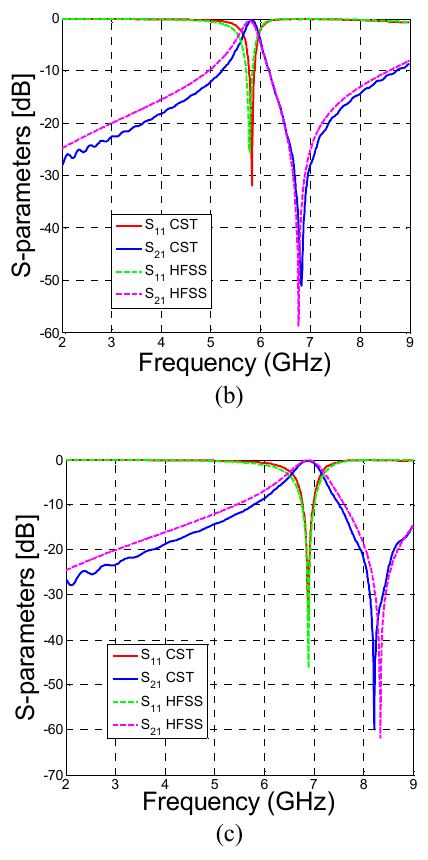
FIGURE 14. Reconfigurable Simulated S parameters of the proposed filter loaded with the diodes D1 and D2 in its three different cases. (a) D1 ON and D2 ON, (b) D1 OFF, D2 ON, (c) D1 ON and D2 OFF. The simulated results after the optimizations of the metamaterial filter are represented in fig.14. showing the S 11 and S 21 of the different cases depending on the diodes.